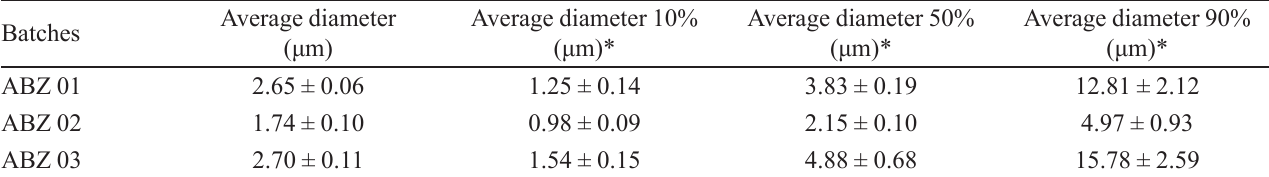
*Population of particles (%) with a diameter lower than the expressed.